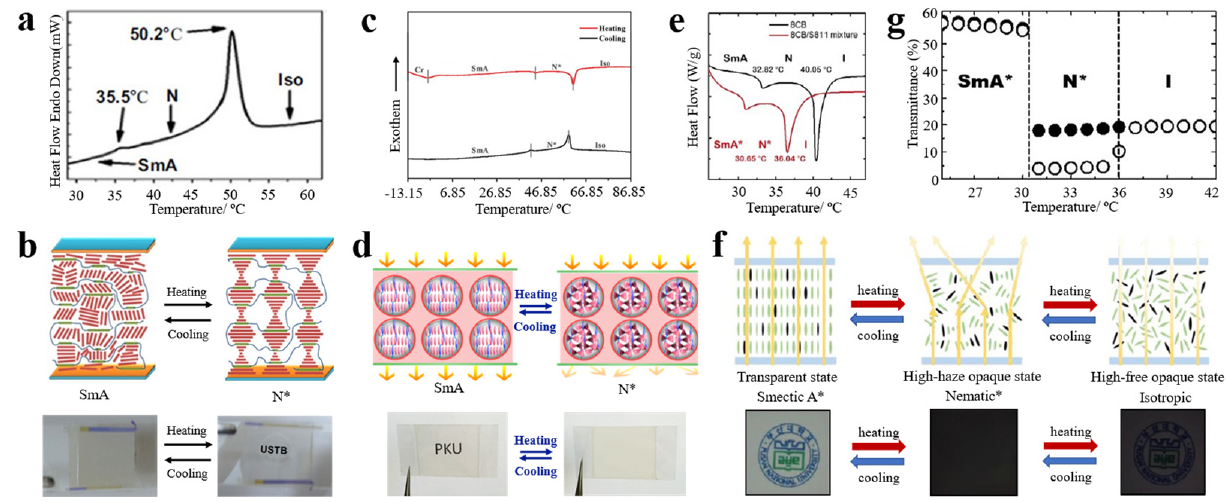
Figure 3. ( a ) DSC curve of the nCB/SLC − 1717 mixtures [78]. ( b ) Schematic representation of the working principle and images of the PSLC film in the cooling/heating states [78]. ( c ) DSC curve of the SmA − LC/SLC − 1717/S811 mixtures [79]. ( d ) Schematic diagrams and images of the PD&SLC film in the cooling/heating states [79]. ( e ) DSC curve of the 8CB/S811 mixtures [80]. ( f ) Schematic representation and photographs of the TRLC film [80]. ( g ) Transmittance of the film with a change in temperature [80]. “*” means the chiral LC phase.